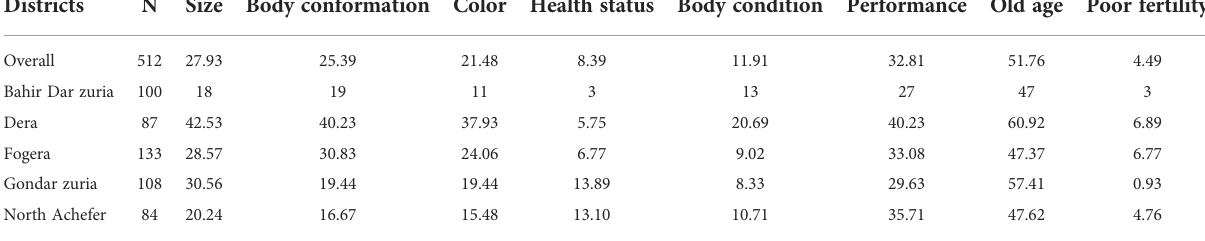
TABLE 5 Weighted proportion (in percent) for the culling criteria of male animals. Districts N